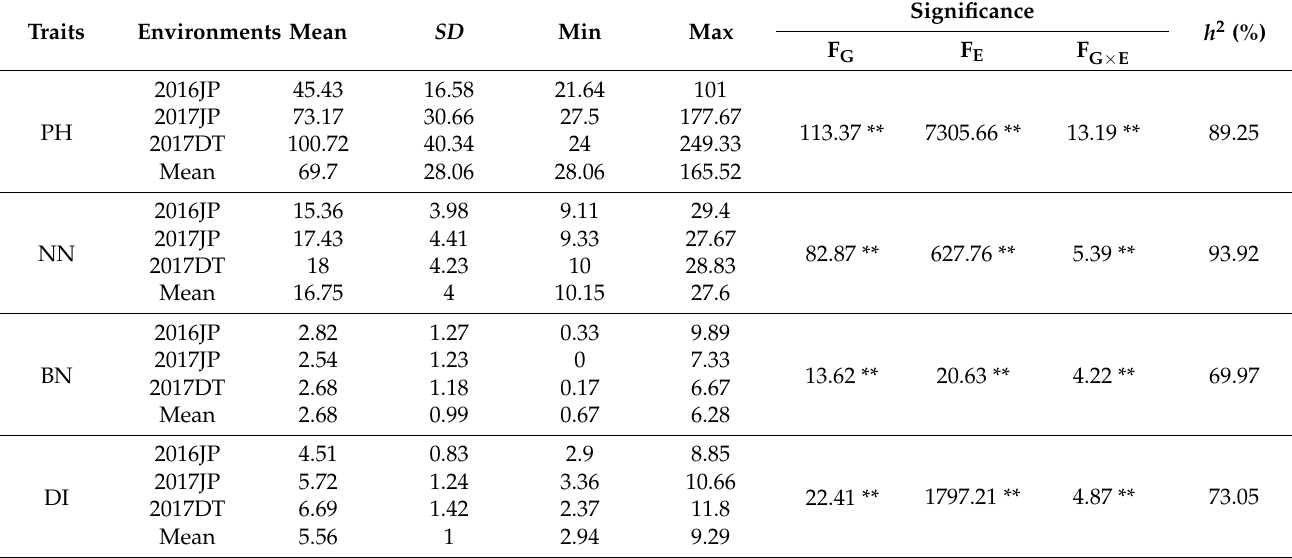
Table 1. Descriptive statistic, analysis of variance, and heritability ( h 2 ) of plant architecture-related traits in soybean mini core collection.